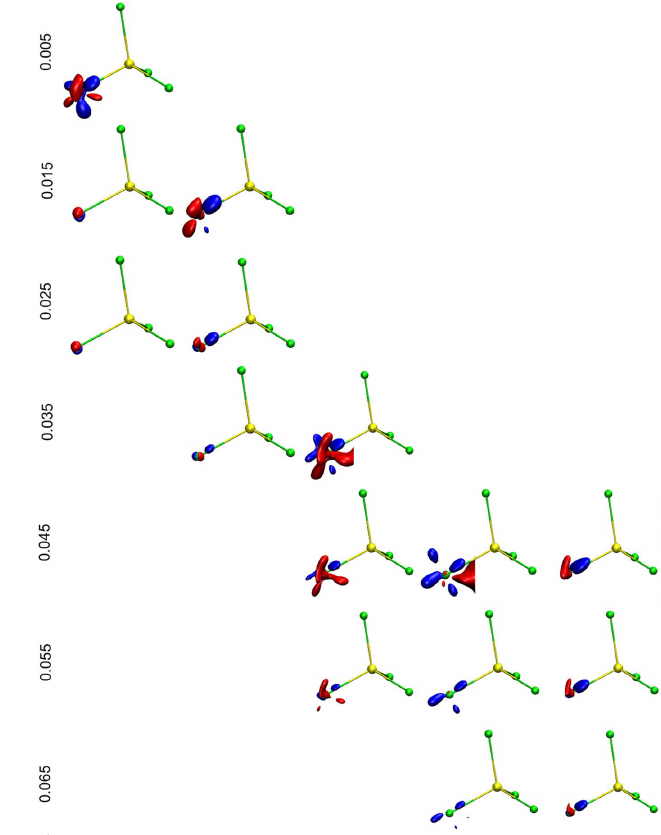
Figure 12 Differences in EDD at the O(9) anion in a range of pressure values from ambient to 40 GPa described by a set of isovalues. The regions in space which carry more total electron density (defined by the isosurface value) at ambient pressure than under particular pressure values are in blue and the regions for which there are more total electron density (as defined by the isocontour value) under pressure than at ambient pressure are in red. So we can interpret such figures as an illustration of the redistribution of charge (at a given contour isosurface value) from the blue regions at ambient pressure to the red regions under higher pressure